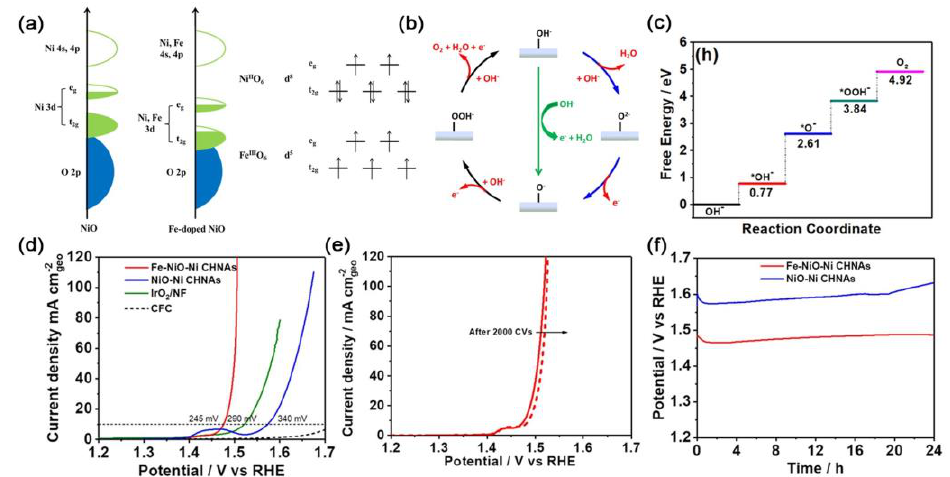
Figure 10. ( a ) Schematic diagram of the band structure of Fe − NiO − Ni CHNAs and NiO − Ni CHNAs. ( b ) Proton − electron transfer pathway and nonconcerted proton – electron transfer pathway of OER. ( c ) Free-energy diagrams of OER for Fe − doped NiO with proton − electron transfer pathway. ( d ) LSV curves of the prepared samples in 1 M KOH at a scan rate of 5 mV s − 1 after i R correction. ( e ) LSV curves of Fe − NiO − Ni CHNAs before and after 2000 CVs. ( f ) E-t curves of Fe-NiO − Ni CHNAs and NiO − Ni CHNAs at current density of 10 mA cm − 2 [110]. Copyright 2020, Elsevier B.V.